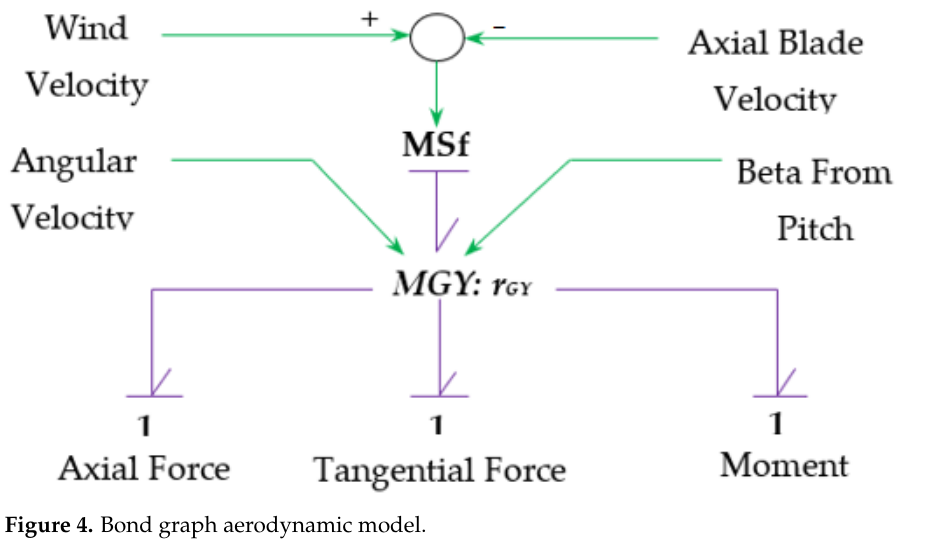
Figure 4. Bond graph aerodynamic model.